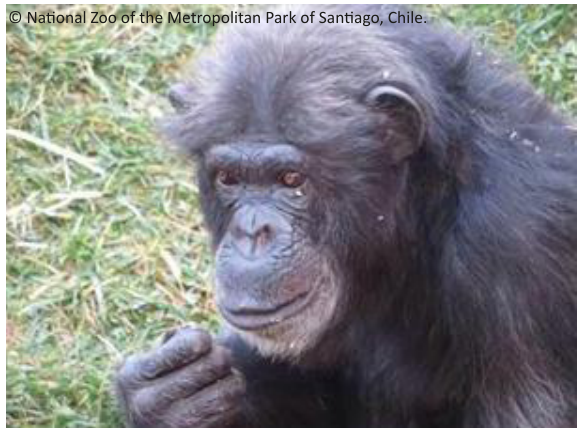
Image 5. Specimen 3- Pan troglody tes